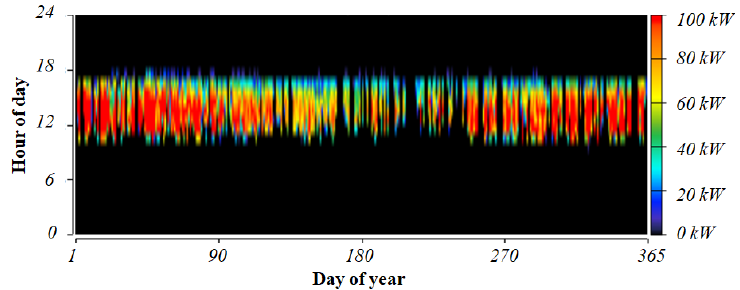
Figure A4. Electrolyser input power in HEGS combination 3.